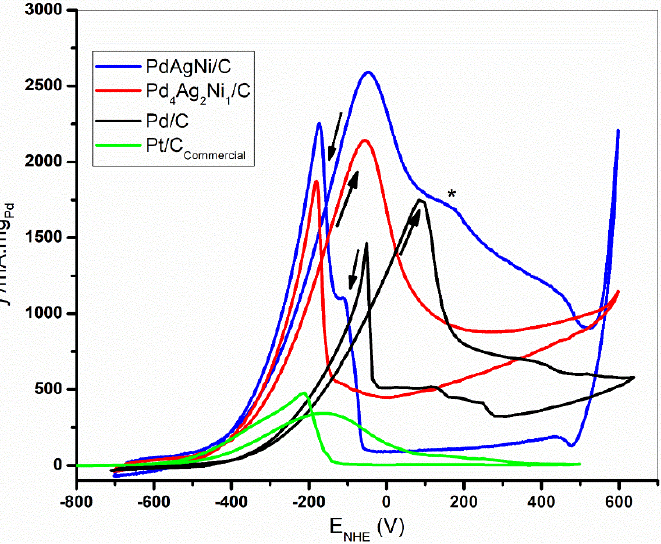
Figure 7. CV Voltammograms of Pd/C, Pd 4 Ag 2 Ni 1 /C, and Pd/C in 1 M KOH+EtOH at 50 mV/s.